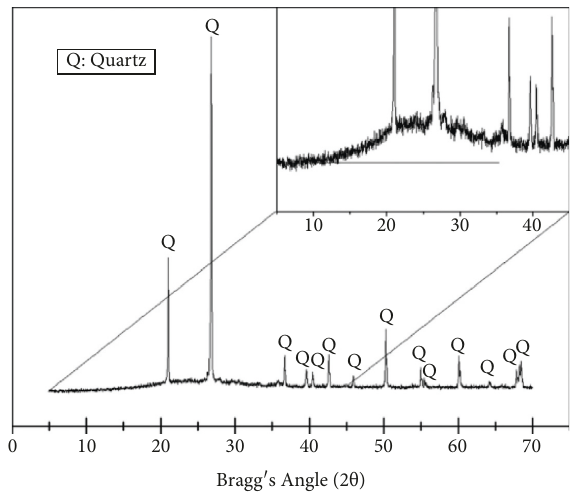
Figure 4: XRD pattern of bamboo leaf ash.